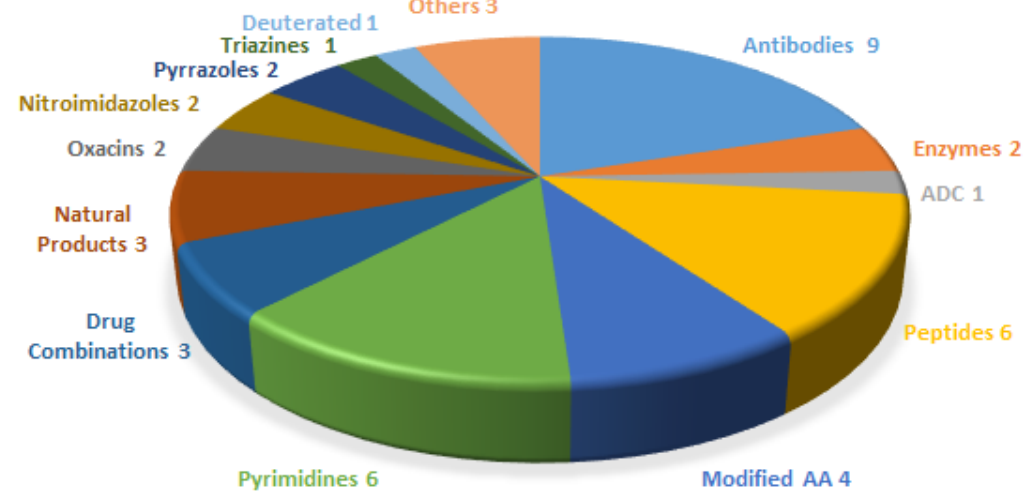
Figure 2. Structure of ( a ) plecanatide and ( b ) the related linaclotide.